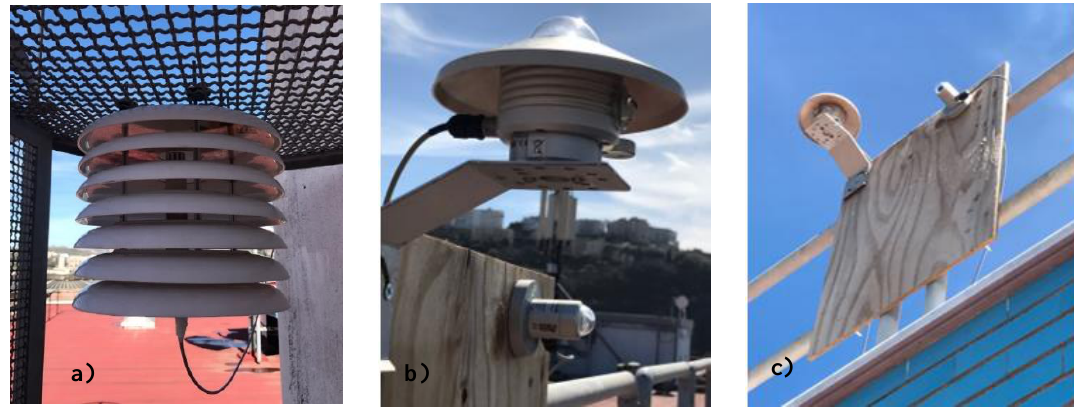
Figure 6. a ) Thermohygrometer in a solar radiation shield. Pyranometers: b ) side and c ) bottom views. Figure6. ( a )Thermohygrometerinasolar radiationshield. Pyranometers: ( b )sideand ( c )bottomviews.